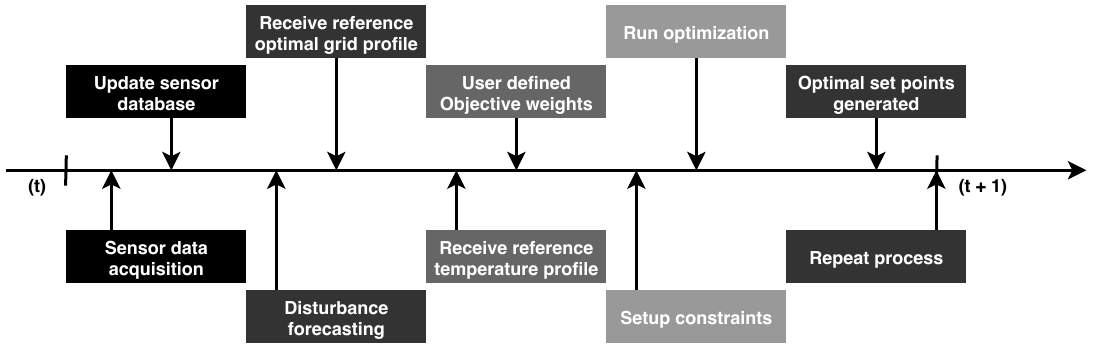
Figure 4. Model predictive control scheme for three-phase HEMS. It describes various functions which are executed for a sample